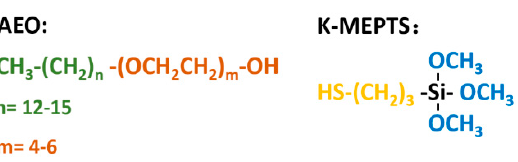
Figure 1. Chemical structure of alcohol polyoxyethylene ether (AEO) and 3-mercaptopropyltriethoxysilane (K-MEPTS).